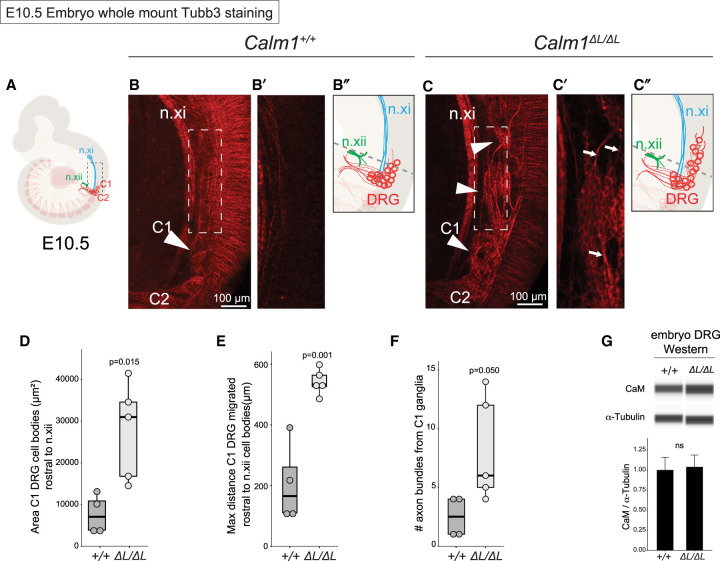
Calm1ΔL/ΔL mice exhibit DRG axon development defects. Developing C1 DRG exhibit axonal and cell body migration disorganization in Calm1ΔL/ΔL E10.5 embryos. (A) Schematic of Calm1+/+ E10.5 embryo highlighting the morphology of the C1 and C2 DRG axons and cell bodies. (B,C) Whole mount Calm1+/+ and Calm1ΔL/ΔL DRG morphology visualized by anti-Tubb3 labeling. (B) The cell bodies of the C1 DRG (arrowhead) in Calm1+/+ embryos are bundled together to form a distinct ganglion. The neurites of the C2 DRG can be seen projecting ventrally in an organized bundle. (C) The C1 DRG in Calm1ΔL/ΔL animals is disorganized and consists of clusters of cell bodies (arrowheads) that extend bundles of axons (arrows). The C1 DRG cells of deletion animals migrate rostral relative to Calm1+/+ and are adjacent to the n.xi tract (B′,C′). Enlarged view of single optical section of same Z-stack from B and C focusing on disorganized mutant cell body morphology of ganglion that aberrantly migrated more rostral relative to control. (D–F) In order to start measurements in the same relative location between embryos, n.xii was used as an anatomical landmark to set a beginning of measurements, indicated by the gray dashed lines in B″,C″. (D) Quantification of area of ectopic cell bodies observed for developing DRG. (E) Distance of aberrantly clustered cell bodies in Calm1+/+ and Calm1ΔL/ΔL. (F) Quantification of the number of axon bundles projecting off C1 ganglia. Significance determined by a t-test; n = 4 C1 DRG Calm1+/+; n = 5 C1 DRG Calm1ΔL/ΔL. n.xi = accessory nerve, n.xii = hypoglossal nerve. (G) Capillary western analysis of Calm1+/+ and Calm1ΔL/ΔL embryonic DRG showing no change in overall protein levels. Significance was determined using a t-test, P = 0.802; n = 3.